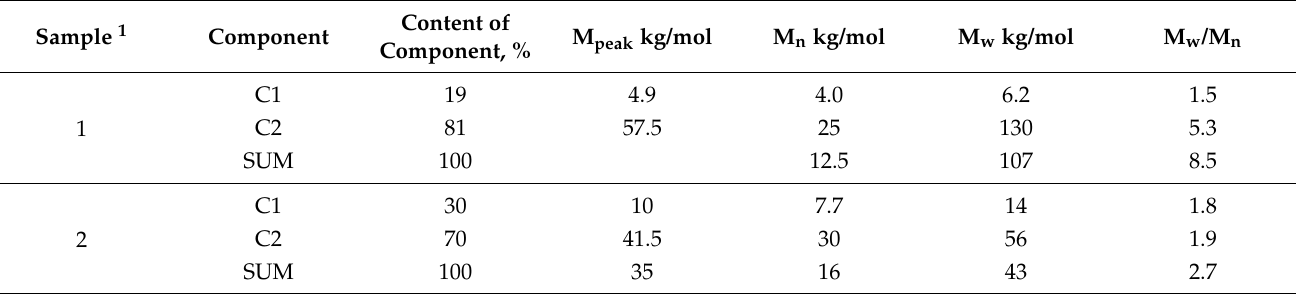
Table 4. Data on molecular weights of separate components C1 and C2 calculated according to the results in Figure